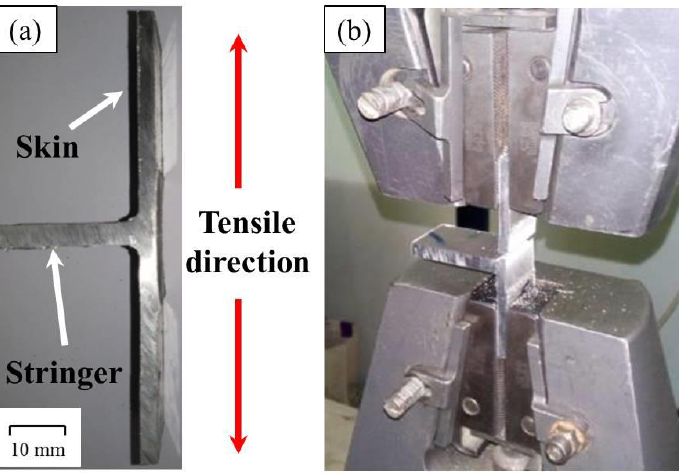
Figure 2. Photographs of tensile testing along skin direction ( a ) T-butt joint tensile test specimen and ( b ) after tensile test.